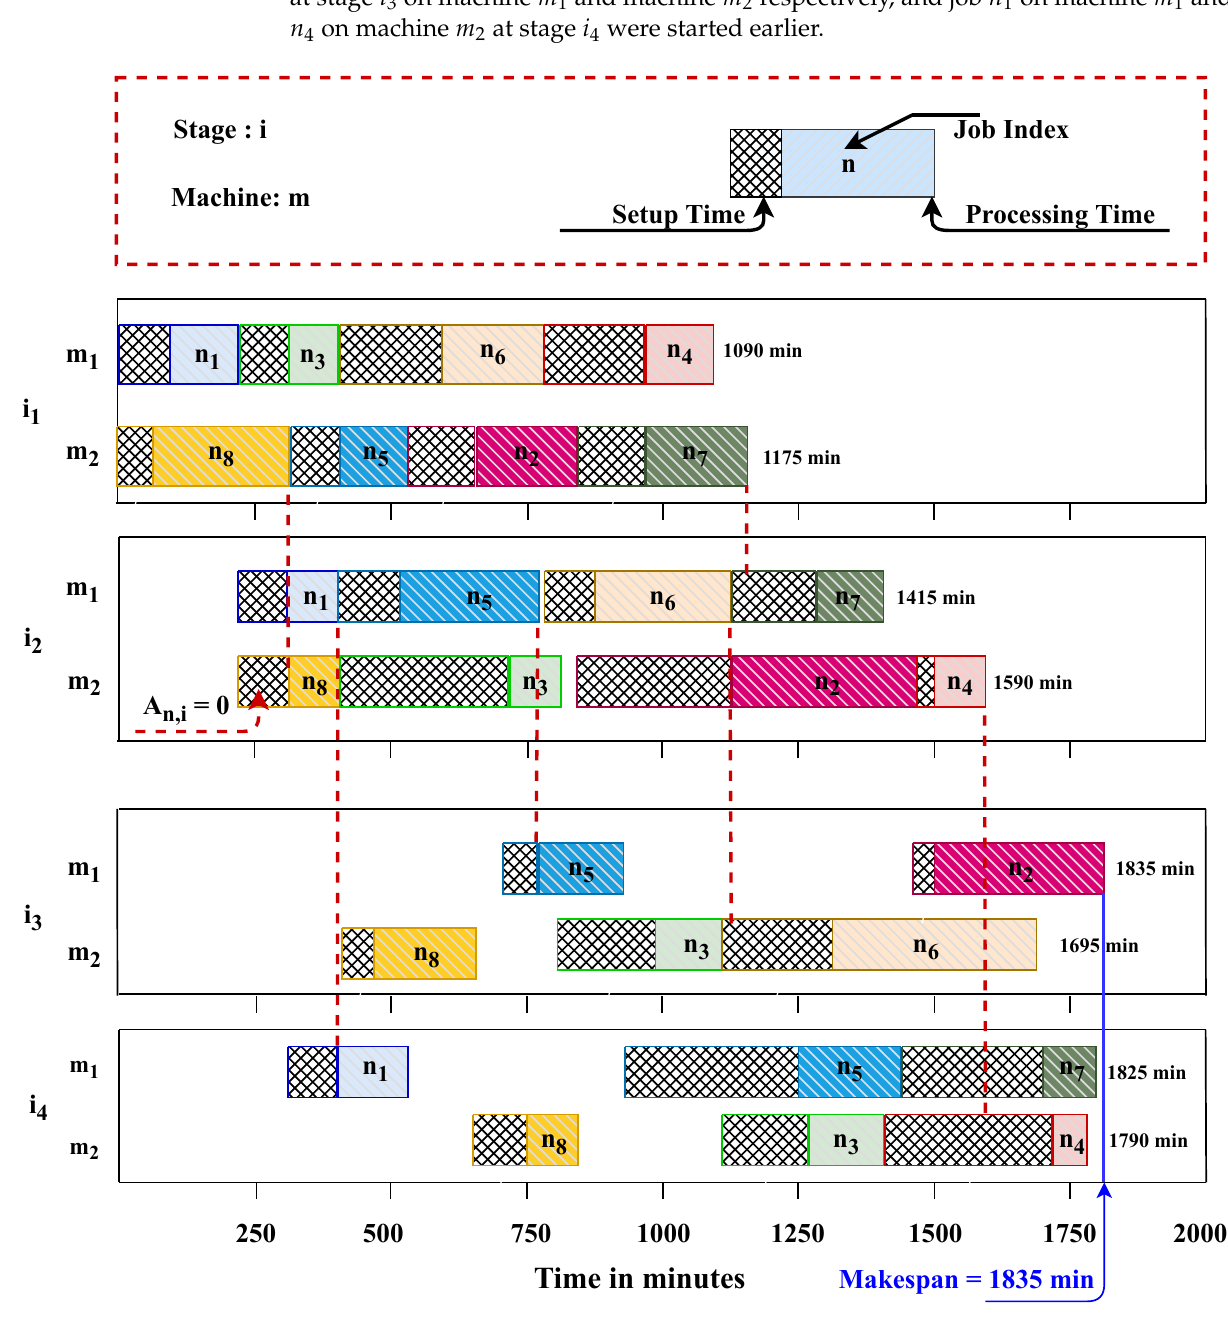
Figure 10. Gantt chart of the scheduling for small prototype problem based on the decoding process stated in Table